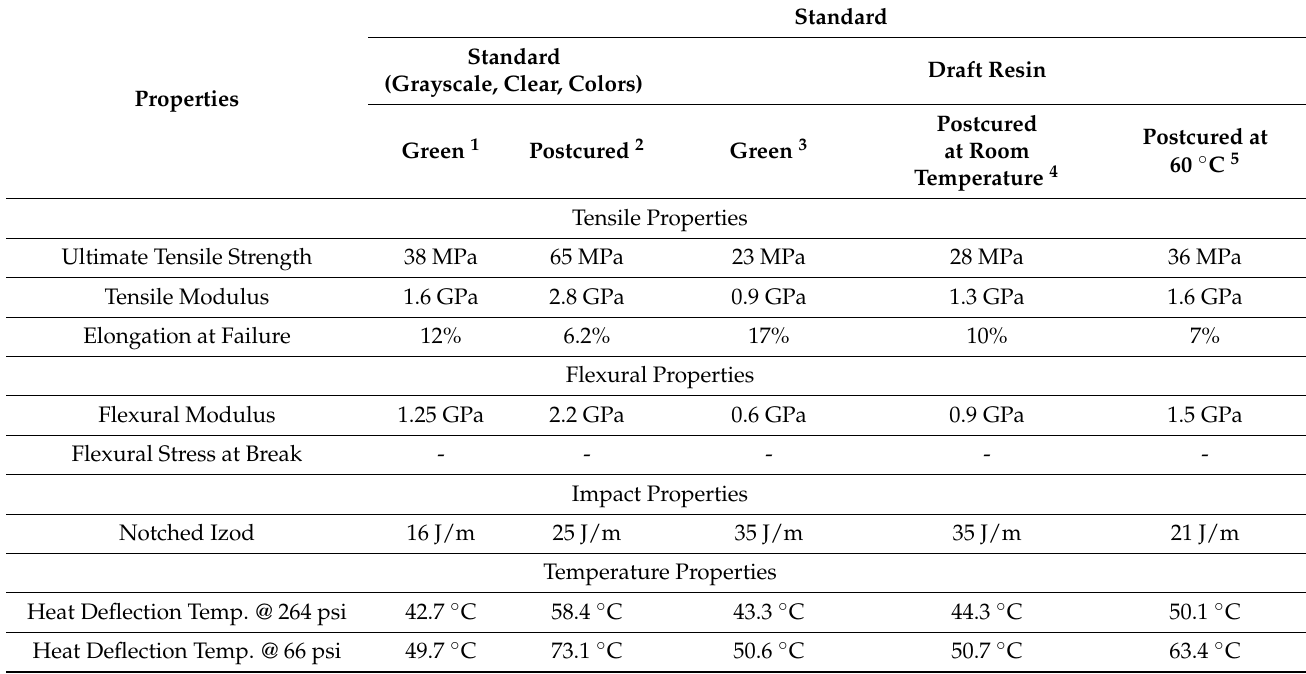
Table 1. Mechanical properties of standard resin